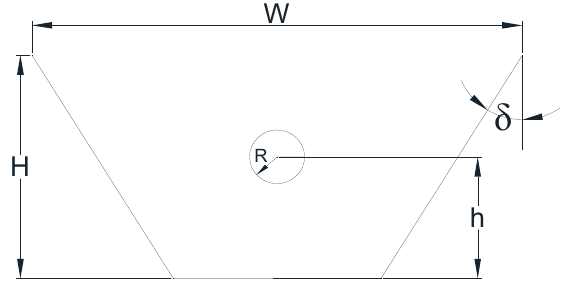
x O R BD Figure 3. Schematic of a SUC model. The curve BD is defined as [32]: ( )